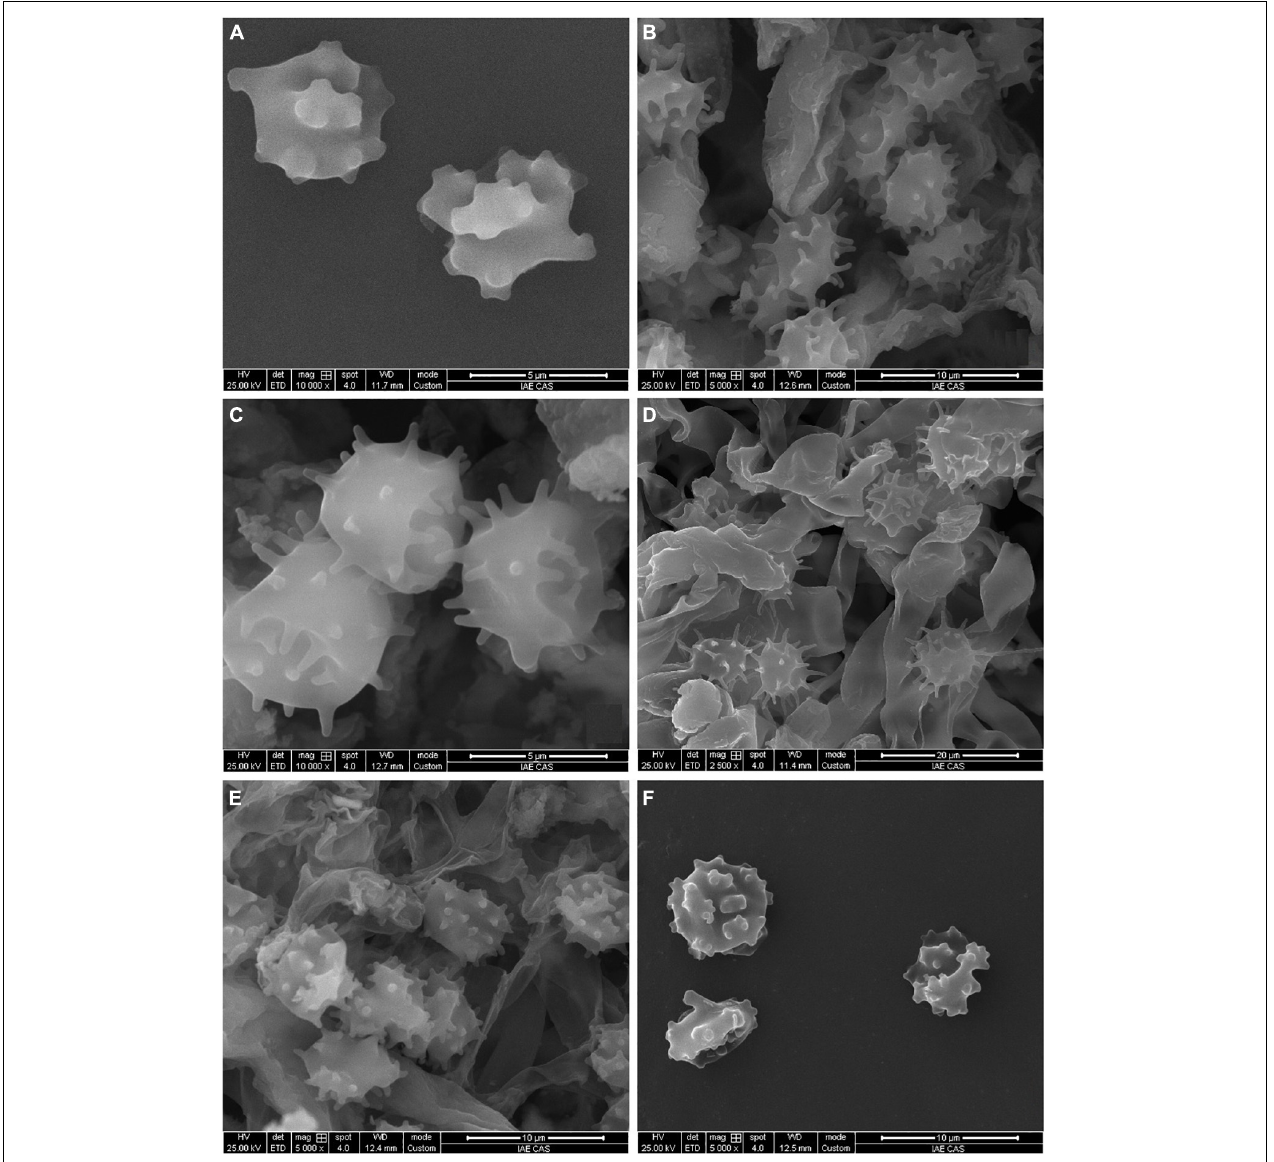
FIGURE 3 | SEM of basidiospores of Tomentella species. (A) T. bidoupensis (holotype Yuan 12707); (B) T. brevisterigmata (holotype Yuan 12700); (C) T. cinereobrunnea (holotype Yuan 12703); (D) T. longiechinula (holotype Yuan 12687); (E) T. stipitobasidia (holotype Yuan 12713); (F) T. verruculata (holotype Yuan